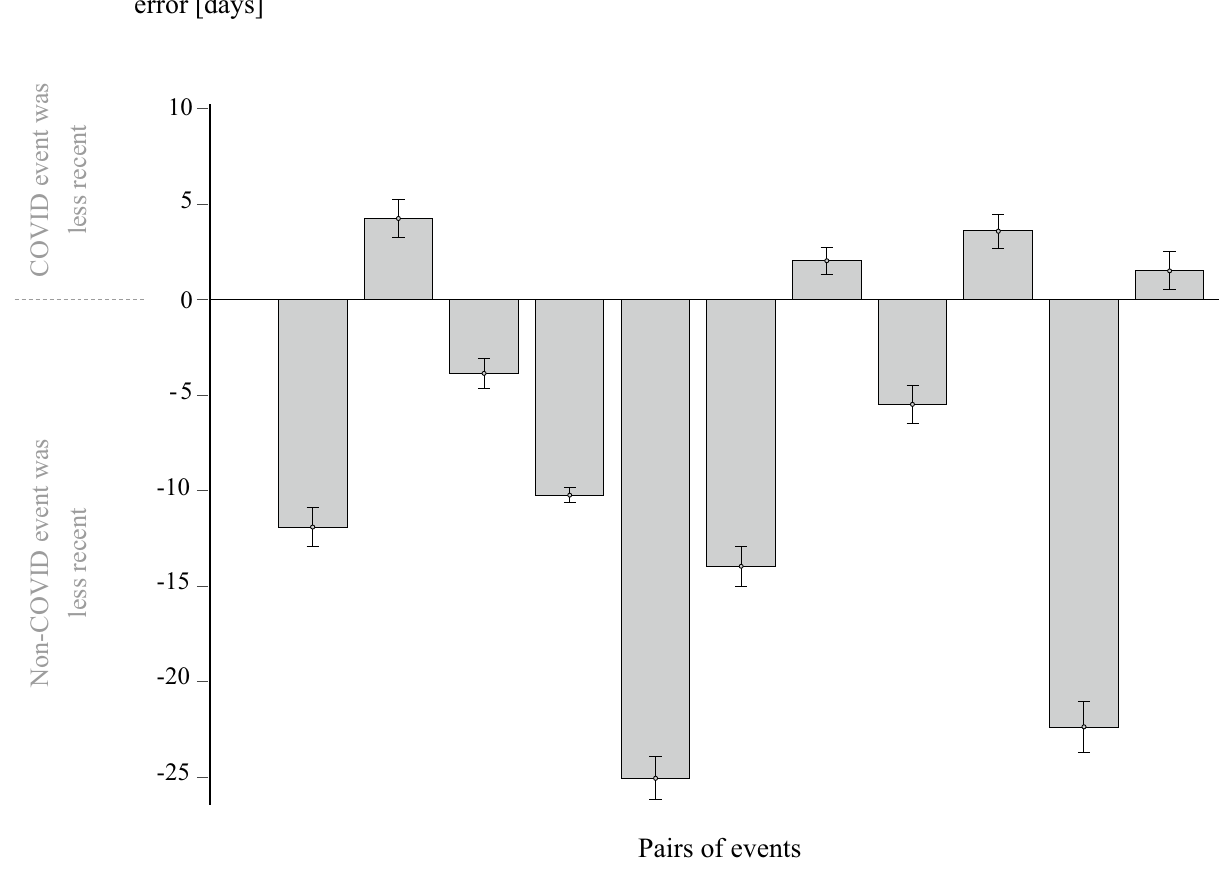
Figure 4. Average estimation errors of time passing between the COVID and the non-COVID event of each of the 11 pairs of events. Zero represent the correct time estimation. Positive values represent estimation errors that placed the COVID event as less recent than it was compared to the non-COVID event. Negative values represent estimation errors that placed the non-COVID event as less recent than it was compared to the COVID event. For most (7/11) pairs, errors indicated that COVID events were perceived as more recent than their counterpart non-COVID